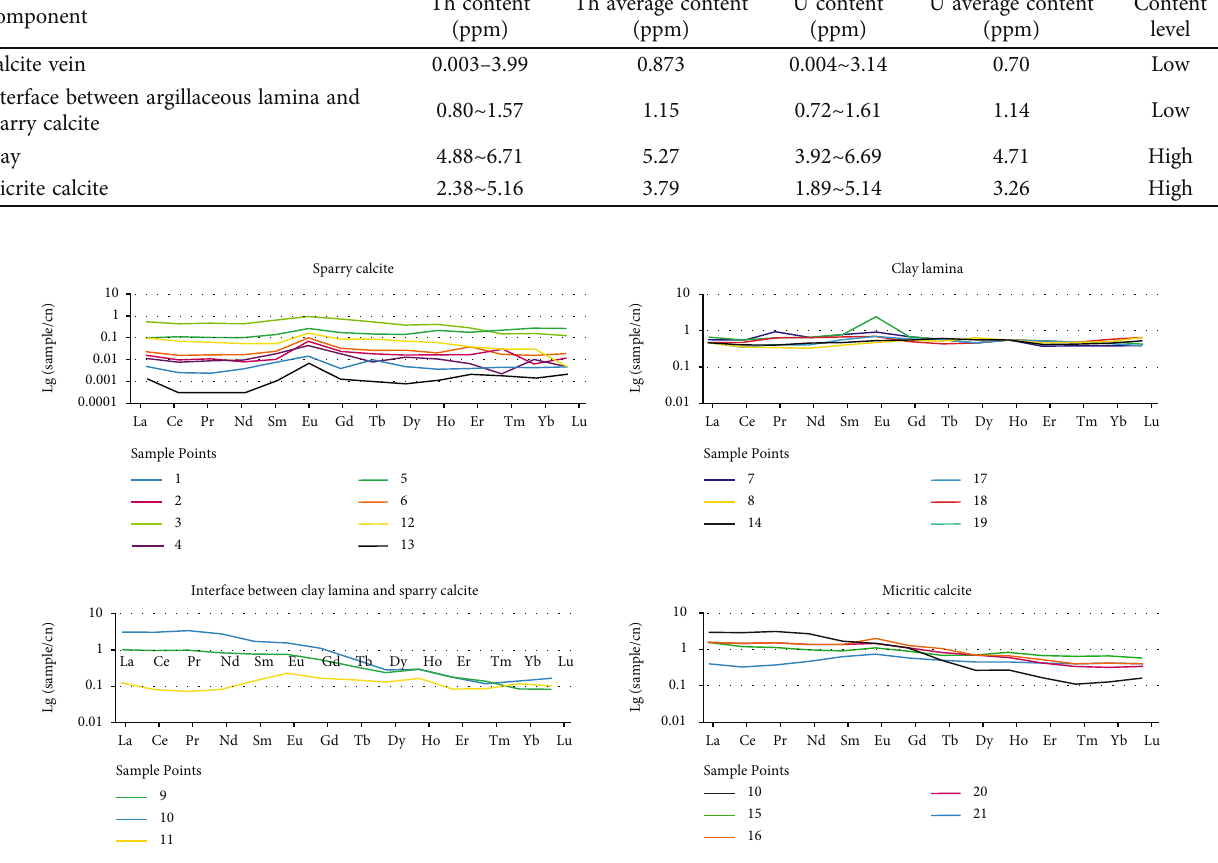
Figure 6: Laminated argillaceous sparry limestone, North American shale-normalized REE partition